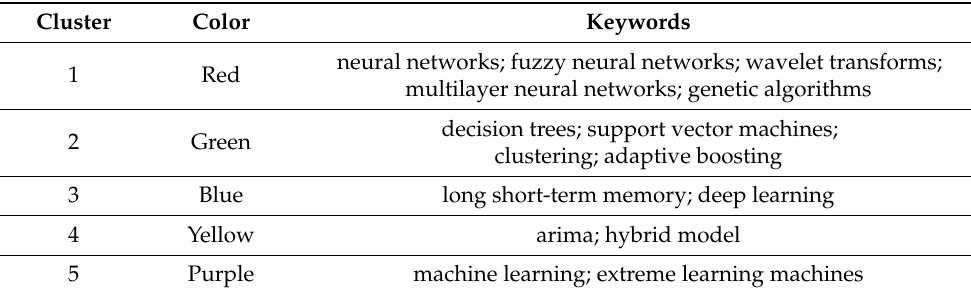
Table 4. Clusters of keywords co-occurrences as presented in Figure 4.